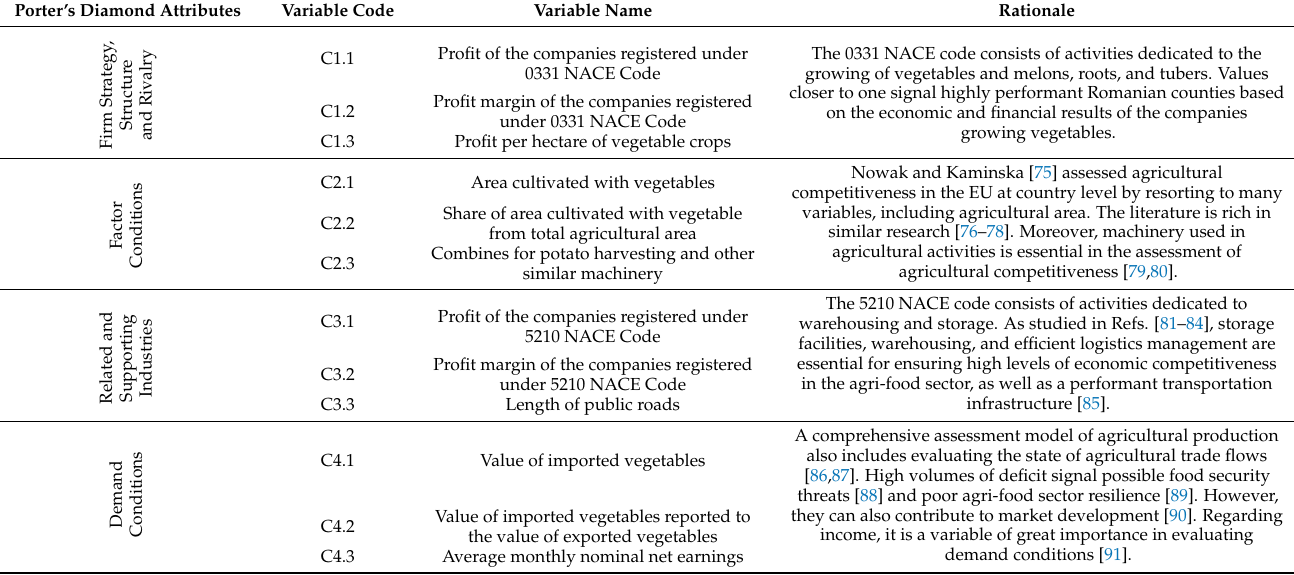
Table 2. Description of the variables considered in the construction of Porter’s diamond